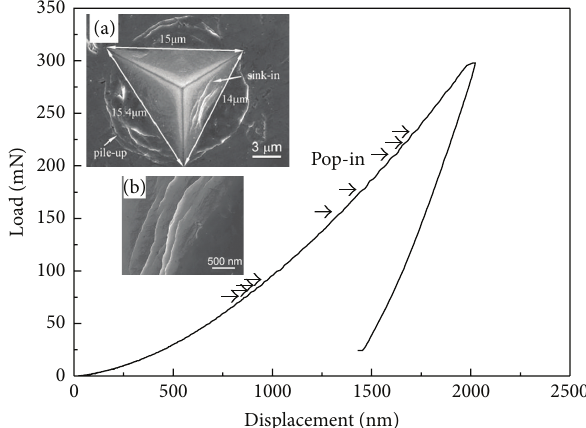
Figure 4: Nanoindentation load-displacement curve of the Pd 81 Si 19 BMG with the inset: (a) SEM of indentation and (b) the enlargement of